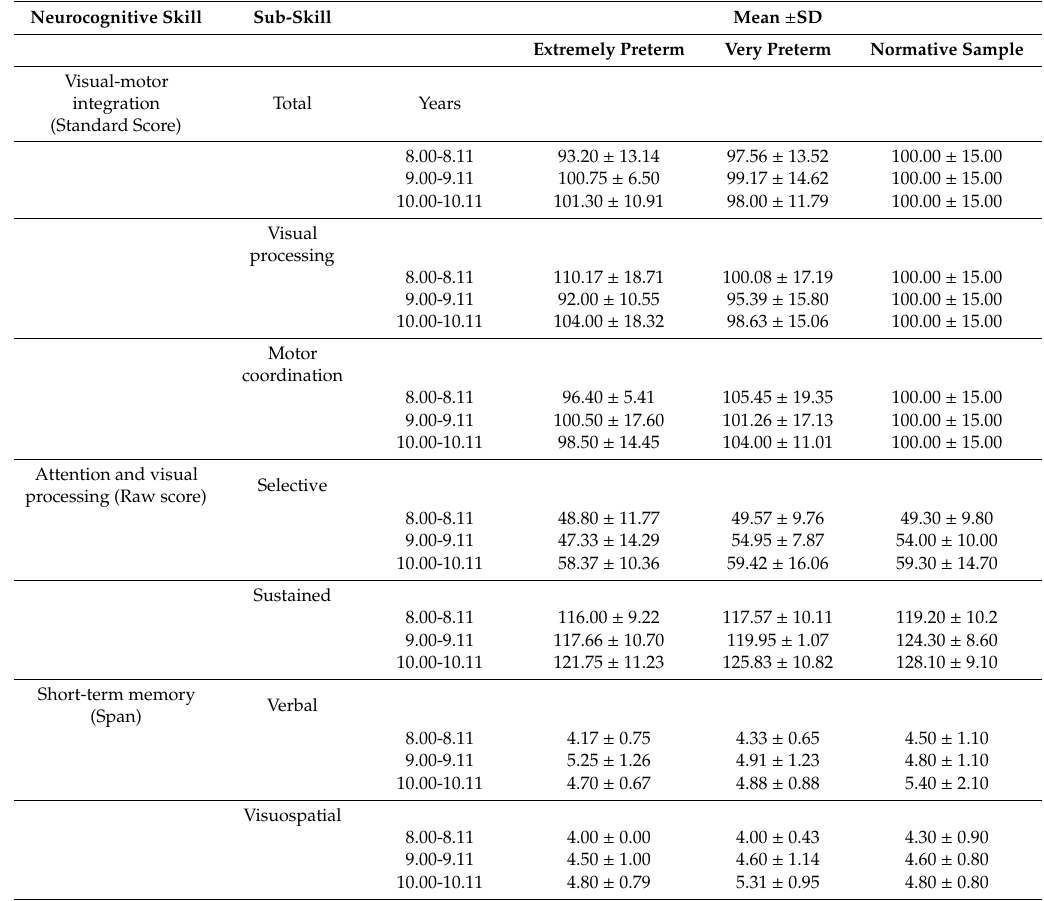
Table A4. Score in Neurocognitive